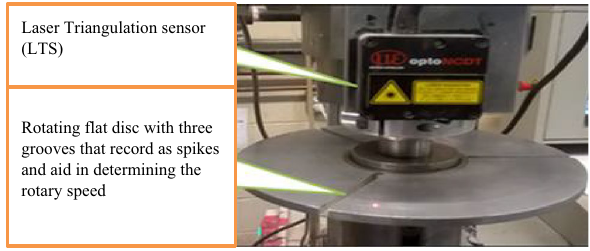
Laser Triangulation sensor (LTS)